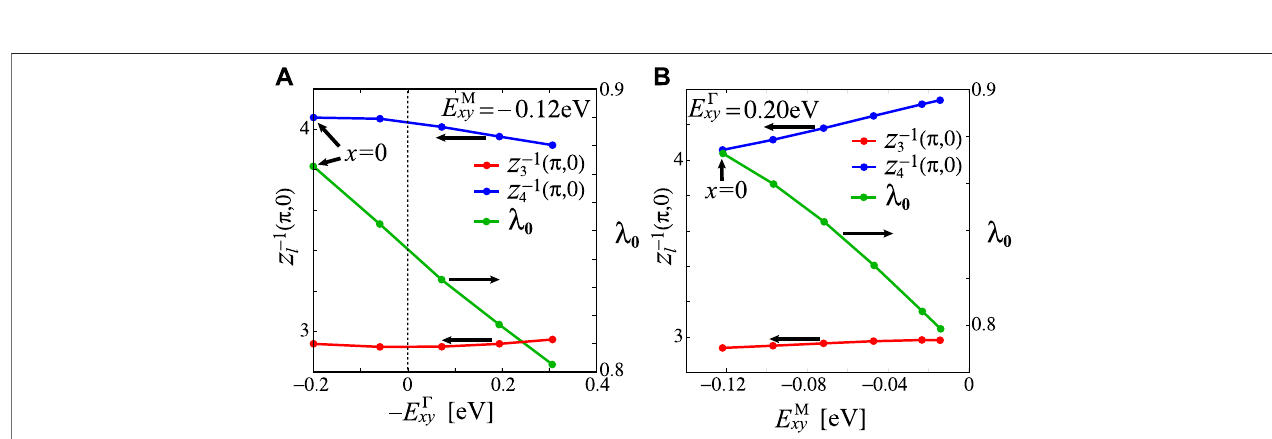
FIGURE9|(A) E Γ xy dependences of z − 1 l ( π , 0 ) for l =3,4, and λ 0 given byintroducing only E Γ xy shift forthe x = 0model. (B) E M xy dependences of z − 1 l ( π , 0 ) for l =3, 4, and λ 0 given by introducing only E M xy shift for the x = 0 model.